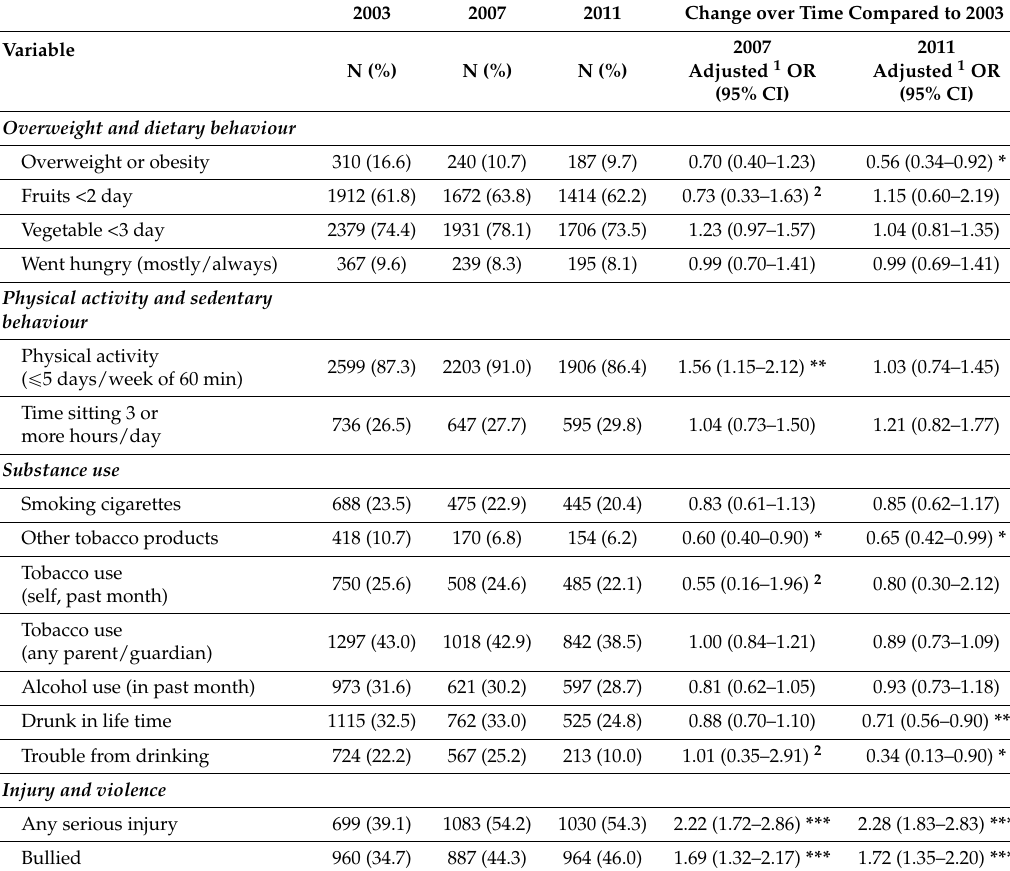
Table 2. Health risk behaviours in 2003, 2007 and 2011 among male in-school adolescents in the